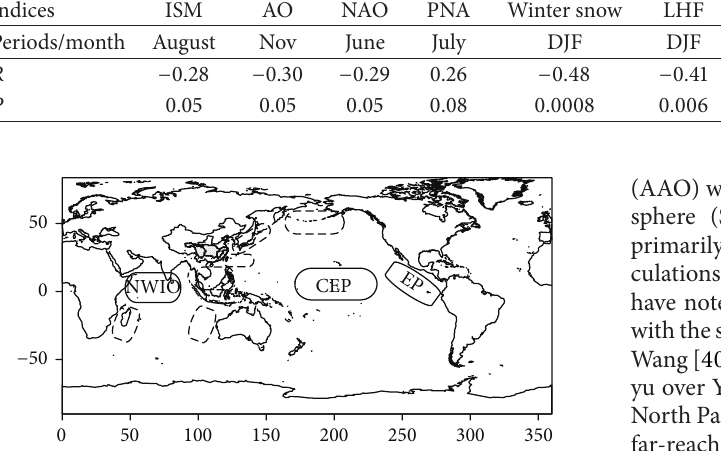
Figure 3: The defined key regions that have significantly affected summer extreme precipitation in YRB according to correlation coefficients over the global ocean. The solid line indicates three key regions selected in the present study. EP: Eastern Pacific; CEP: Central Equatorial Pacific; NWIO: Northwest Indian Ocean. Dashed boxes represent insignificant